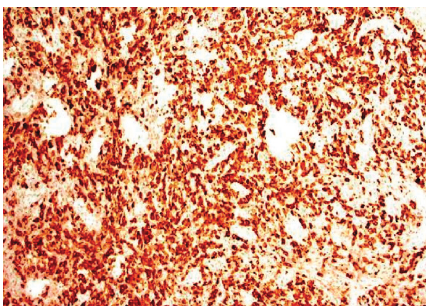
Figure 4: Inguinal lymph node CD30+ stain.